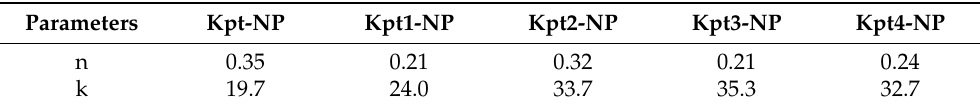
Table 5. Calculation results of Korsmeyer–Peppas model